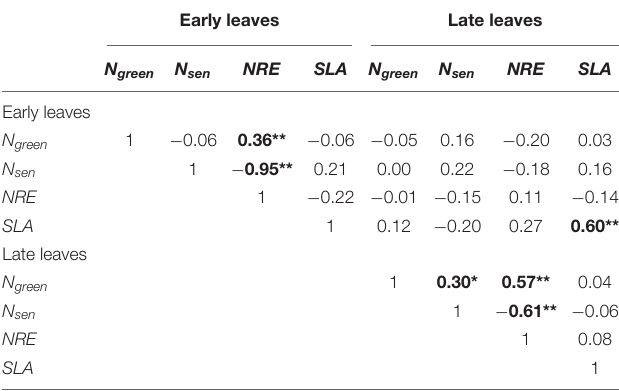
TABLE 2 | Pearson’s correlation coefficient ( r ) matrix for the different leaf traits of early and late leaves. Early leaves Late